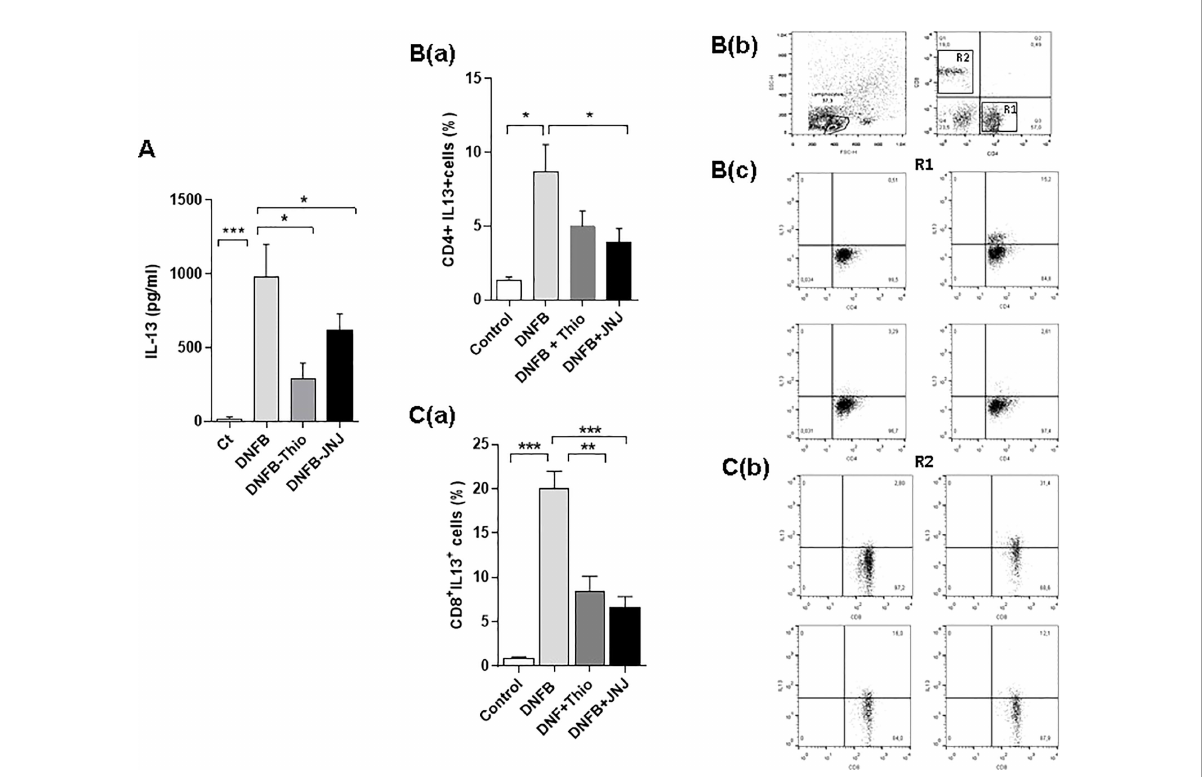
FIGURE 3 Blockade of H 3 R and H 4 R decreases the production of IL-13 in T lymphocytes. The determinations were made after 24 hours of stimulation of the cells with PMA (10 ng/ml) + ionomycin (1 ng/ml). (A) Quanti fi cation by ELISA in culture supernatants is shown. * p < 0.05; *** p >0.001. ANOVA with Tukey ’ s post-test ( n = 7). The content of IL-13 in R1, corresponding to CD4 + cells ( B , panel a), and in R2, corresponding to CD8 + ( C , panel a) lymphocytes, is shown. The intracytoplasmic marking and fl ow cytometry, in the presence of brefeldin (10 µg/ml). The cells were permeabilized and labeled with PE-labeled IL-13 antibody. Bars represent the mean + SEM. * p < 0.05; ** p >0.01; *** p < 0.001. ANOVA with Tukey ’ s post-test ( n = 9). A representative fl uorescence dot plot of CD4 + ( B , panel c) and CD8 + ( C , panel b) lymphocytes is